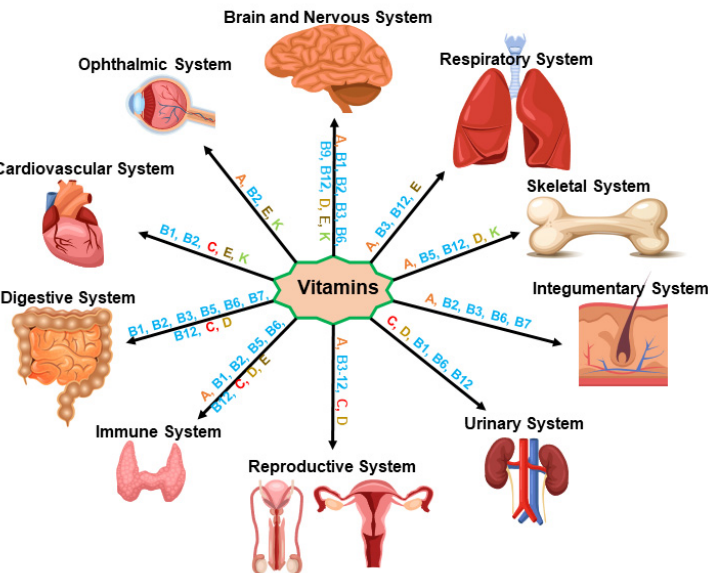
Figure 3. A diagram illustrating the roles of various vitamins on different organ systems. All of these vitamins play important roles in the immune system, in addition to growth and development of various organs and, thus, physiological activities. Organ systems illustrated are the brain and nerv- ous system, respiratory system, skeletal system, integumentary system, urinary system, reproduc- tive system, immune system, digestive system, cardiovascular system, and ophthalmic system. In- volvement of different vitamins to a particular organ is shown by a line pointing an arrow to the specific organ